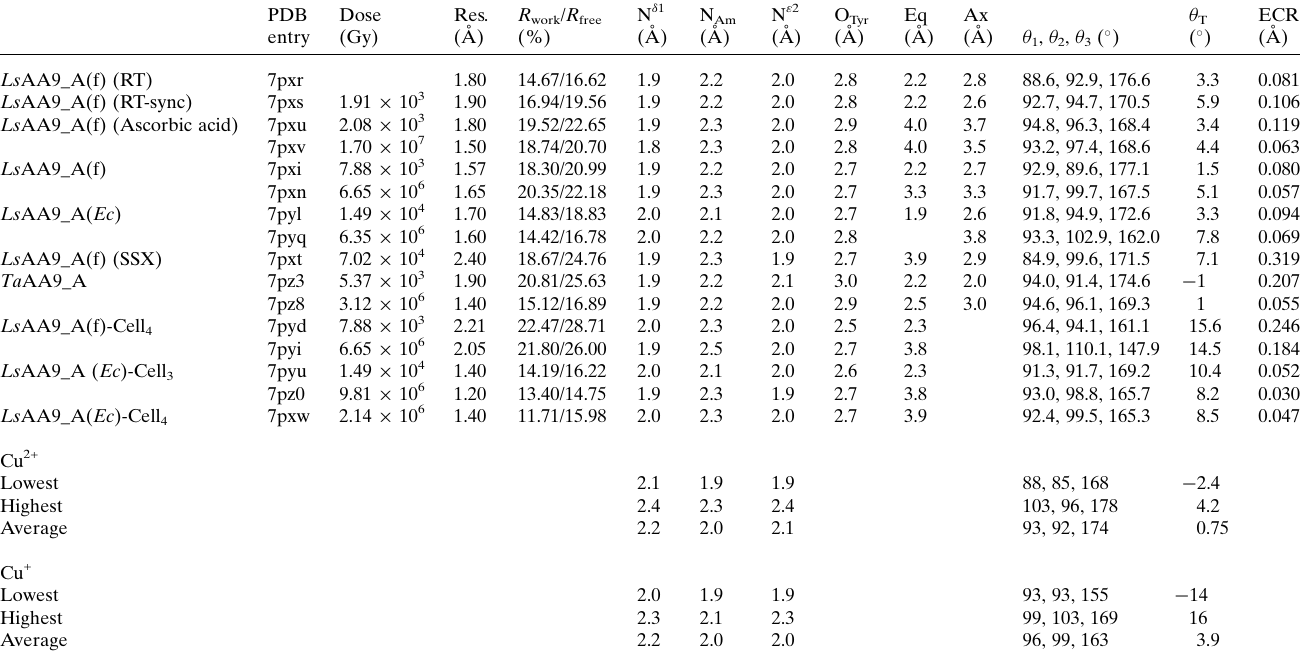
Table 3 Structural parameters within the LPMO Cu site. The lowest and highest X-ray dose structures are listed, together with additional reference structures. Distances (between the indicated atom and Cu) and angles were measured in Coot (Emsley & Cowtan, 2004) and using the Biopython module (Cock et al. , 2009). In cases where a ligand atom is modelled in a double conformation, the distance is an average weighted by the occupancy of the atom. Further structural parameters for all structures are presented in Tables S7 and S8. Res = high-resolution limit. Distances are measured from Cu to the indicated atom. (cid:2) 1 , (cid:2) 2 , (cid:2) 3 and (cid:2) T ( (cid:3) ) are defined in Vu & Ngo (2018). The lowest/highest/average distance and (cid:2) 1 , (cid:2) 2 , (cid:2) 3 and (cid:2) T ( (cid:3) ) for Cu 2+ /Cu + structures are from Vu & Ngo (2018). ECR = estimated coordinate error based on the R value; value extracted from the REFMAC5 output PDB